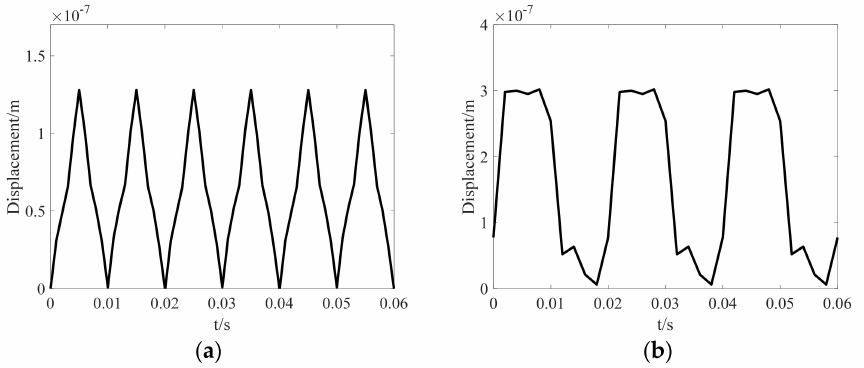
Figure 13. Waveforms of displacement on point A under di ff erent magnetizations: ( a ) The fifth harmonic accounts for 50% of the fundamental component ( B 1 = 0.8 T, B 5 = 0.4 T); ( b ) DC bias of 1A ( B 1 = 0.8 T, H dc = 76 A /